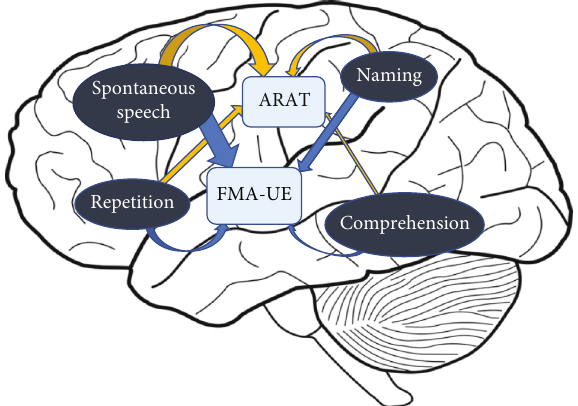
Figure 5: The association between UE motor status and language function after PSA. Schematic diagram shows partial correlations in an eight-way analysis of FMA-UE; ARAT; and spontaneous speech, comprehension, repetition, and naming. The degree of the arrow thickness between two modules is proportional to the correlation coe ffi cient. FMA-UE indicates the Fugl-Meyer assessment for the upper extremity; ARAT indicates the action research and action